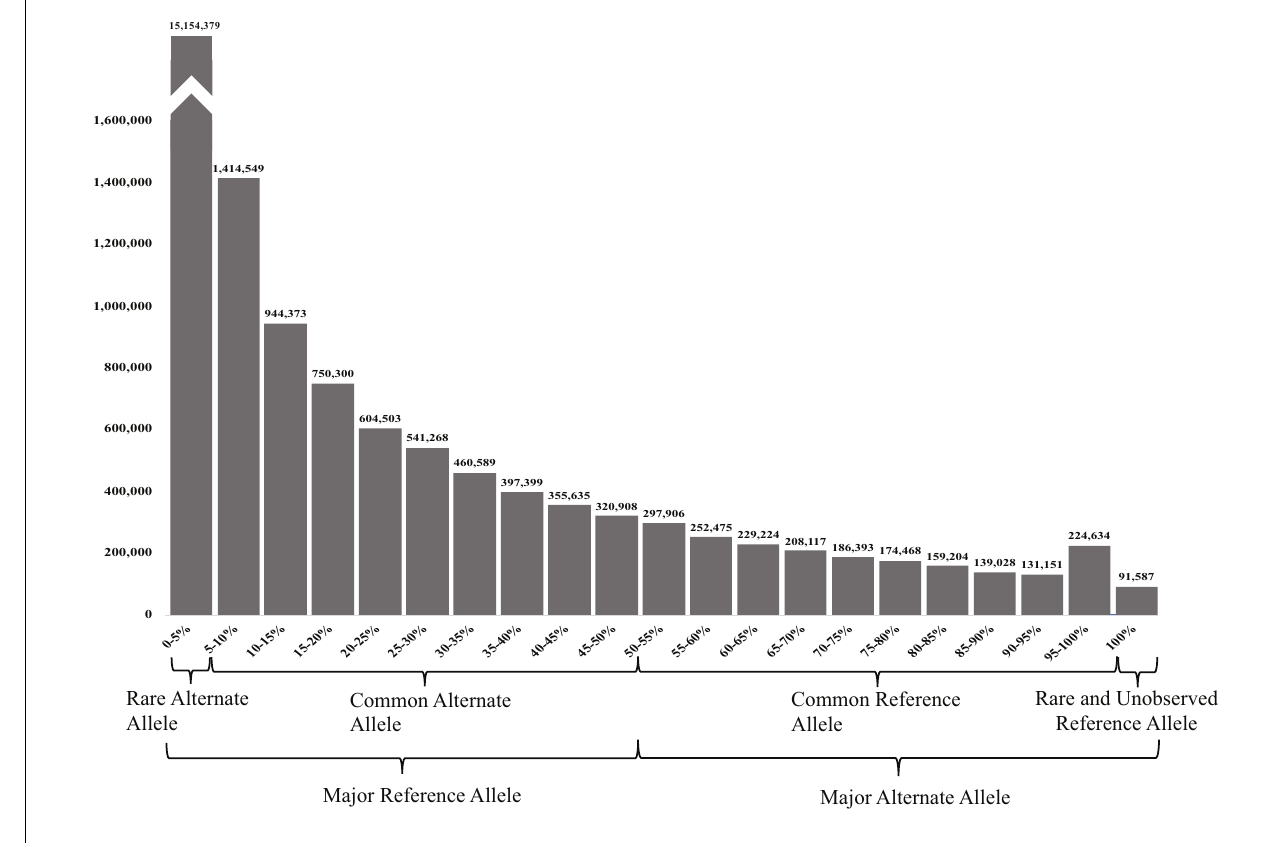
FIGURE 3 | Allele frequency (AF) histogram of all filtered variants identified in the 153 samples. The histogram shows the number of variants against their AFs in (5% intervals). The highest peak represents the number of variants with rare alternate AFs of < 5%, while the less common (lowest number of variants) had the rare or unobserved reference allele with 100% alternate